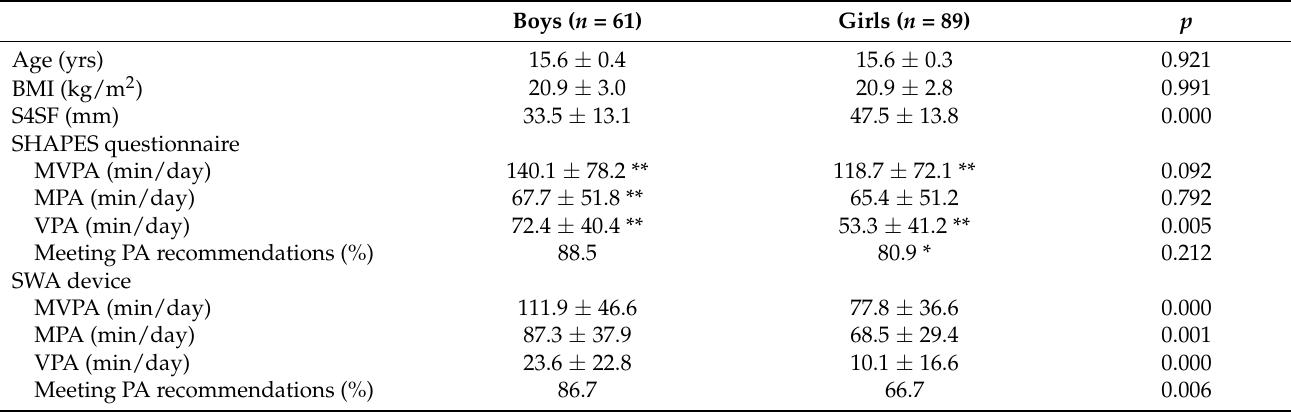
Table 1. Basic descriptive parameters of the sample and differences between female and male study participants determined using t-test and Mann-Whitney U test.